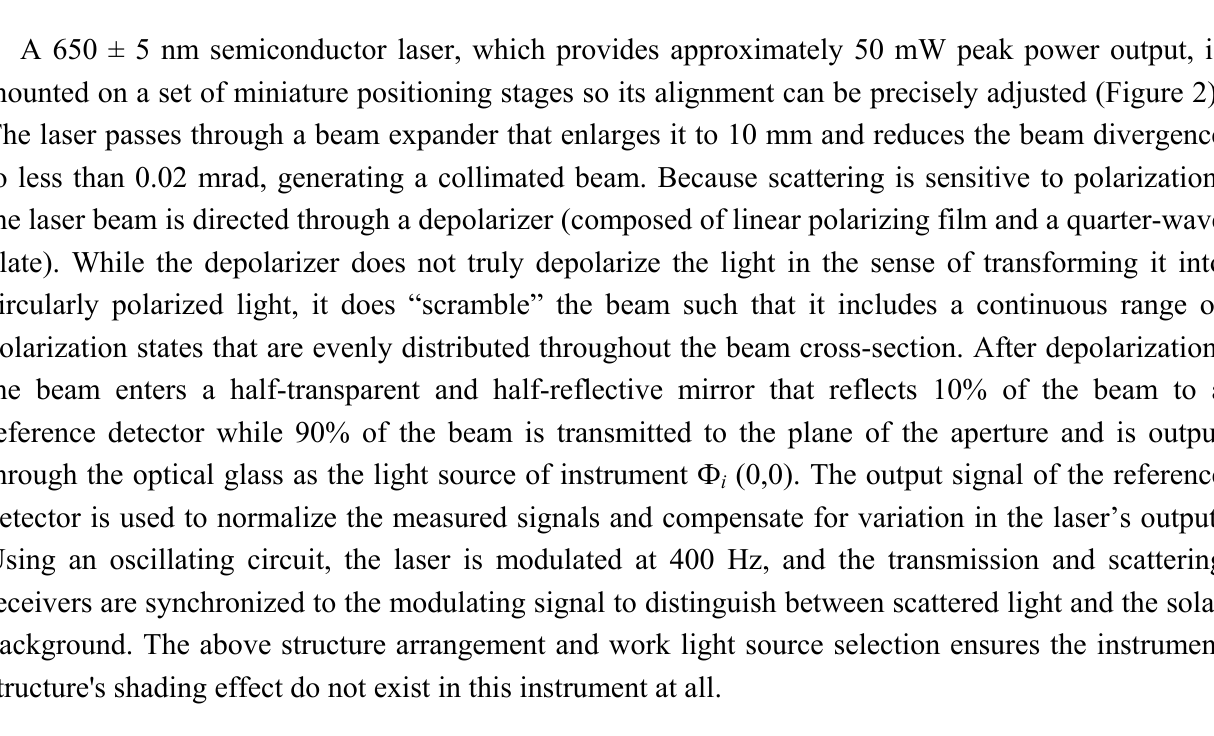
Figure 2. ( a ) Architecture of the array general-angle volume scattering function measuring instrument; ( b ) Optical structure of the measuring instrument (light source and